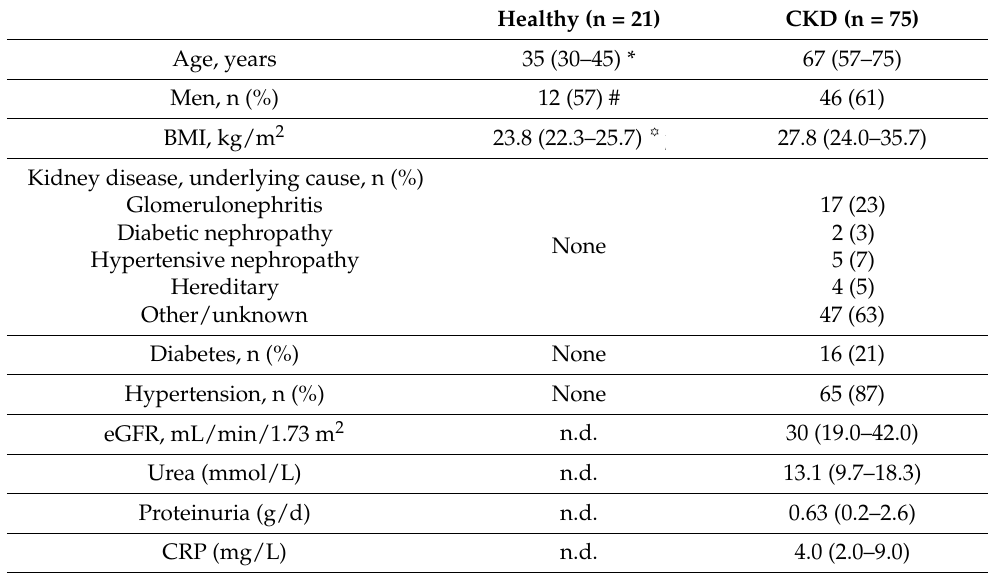
Table 1. Clinical and biochemical population characteristics of patients with chronic kidney disease and healthy control subjects, given as median (25–75% percentile) or number (percentage).